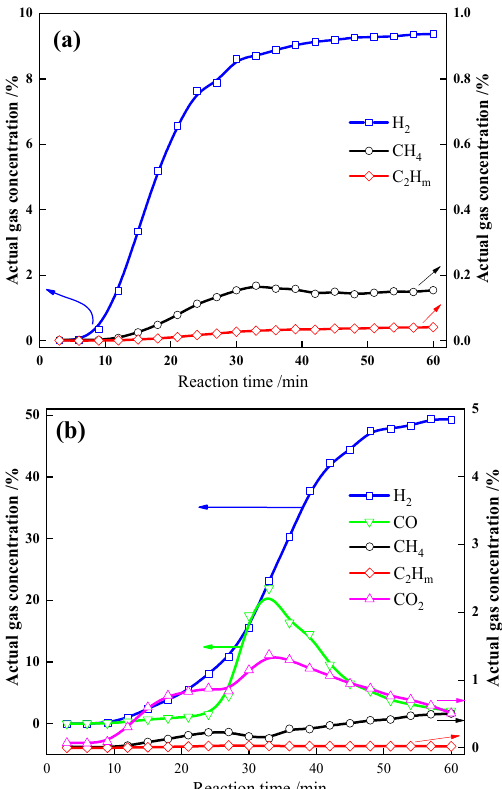
Figure 2. The behavioral comparisons of benzene cracked by: ( a ) SiO 2 and ( b ) Hematite. In the blank experiment (using SiO 2 ), the gas concentrations were low, the main gas component was H 2 (95.40%) and the CH 4 (3.91%) and C 2 H m (0.69%) contents were low. The oxygenated gases (CO and CO 2 ) were not observed. H 2 concentration increased grad- ually in the first 30 min before stabilizing. Additionally, the benzene conversion, H 2 yield, and carbon deposition were 55.37%, 7.22%, and 1.98%, respectively. These results indicate that the self-cracking performance of benzene at high temperatures was low, since the inert SiO 2 carrier had no oxidation and catalysis ability. During this process, the reaction R1 played a major role [41]. Although the benzene conversion was 55.37%, the majority of benzene only partially cracked and only a small portion of its C-H/C-C bonds was com- pletely broken. Thus, the H 2 yield (gas product) and carbon deposition (solid product) were very low, and a large amount of benzene series (liquid product) was generated, as shown in R2. Benzene dehydrogenation mostly generates benzene radicals, which later combine with other radicals to form a new, larger benzene series. The mass of the gener- ated liquid products was 1.20 g and the main component (biphenyl) accounted for 75.83% of that mass. However, hematite addition accelerated the benzene cracking. Along with the H 2 , CH 4 , and C 2 H m , a large amount of oxygen-containing gases (CO and CO 2 ) was generated. In the initial stage, a small amount of absorbed oxygen reacted with the benzene on the surface of the hematite, which leads to the formation of CO and CO 2 . After 25 min, the CO concentration increased and reached its peak at 33 min, indicating that lattice oxygen was involved in the benzene oxidation. In the final stage, lattice oxygen was absent, making it impossible to meet the oxygen demand of benzene oxidation, but part of the OC was re- duced to metal Fe, which catalyzed the benzene cracking. Therefore, CO concentration declined gradually, and the H 2 concentration increased continuously. Furthermore, compared to the blank experiment, the benzene conversion, H 2 yield and carbon deposition increased to 69.05%, 21.96%, and 39.13%, respectively. Hematite has the dual function of oxidation and catalysis. First, benzene underwent an oxidation-